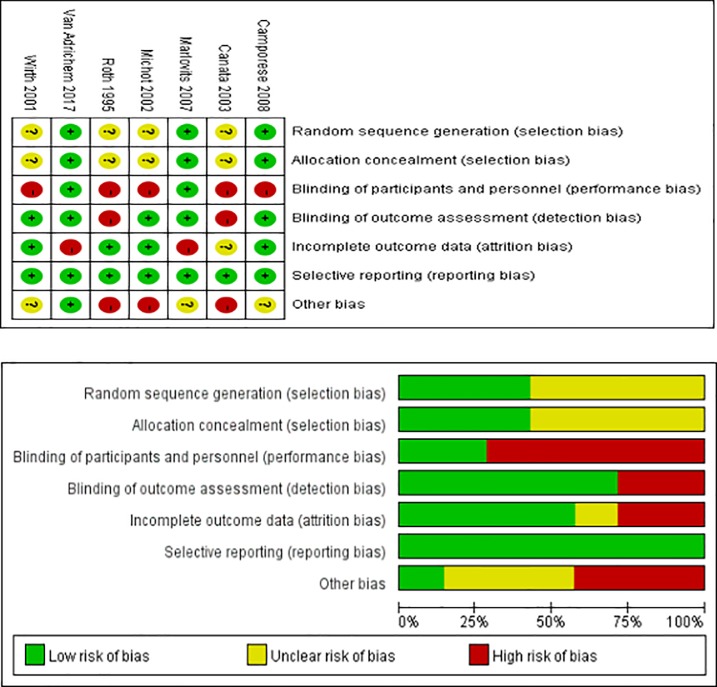
Risk of bias of the selected studies according to the Cochrane Collaboration tool.Panel A: Risk of bias graph: judgement regarding each risk of bias item presented as percentages across all studies. Panel B: Risk of bias summary: judgement regarding each risk of bias item for each study. A (+), indicates a low risk of bias; a (-), indicates a high risk of bias; and a (?), indicates an unclear risk of bias. All assessments were determined by consensus of the two independent authors.